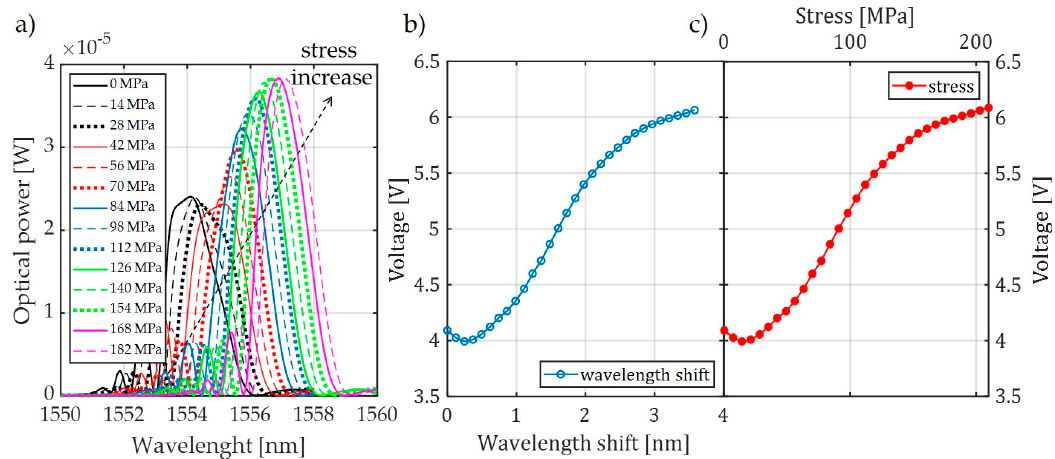
Figure 13. Measurement results in the interrogator system showed in Figure 3b for the FBG + FBGF2 matched gratings pair: ( a ) change in the shape of the system output signal due to stress change; ( b ) conversion characteristics of the wavelength shift into a voltage change measured on the photodetector; ( c ) characteristics of the power line conductor stress conversion to changes in the voltage on the photodetector.